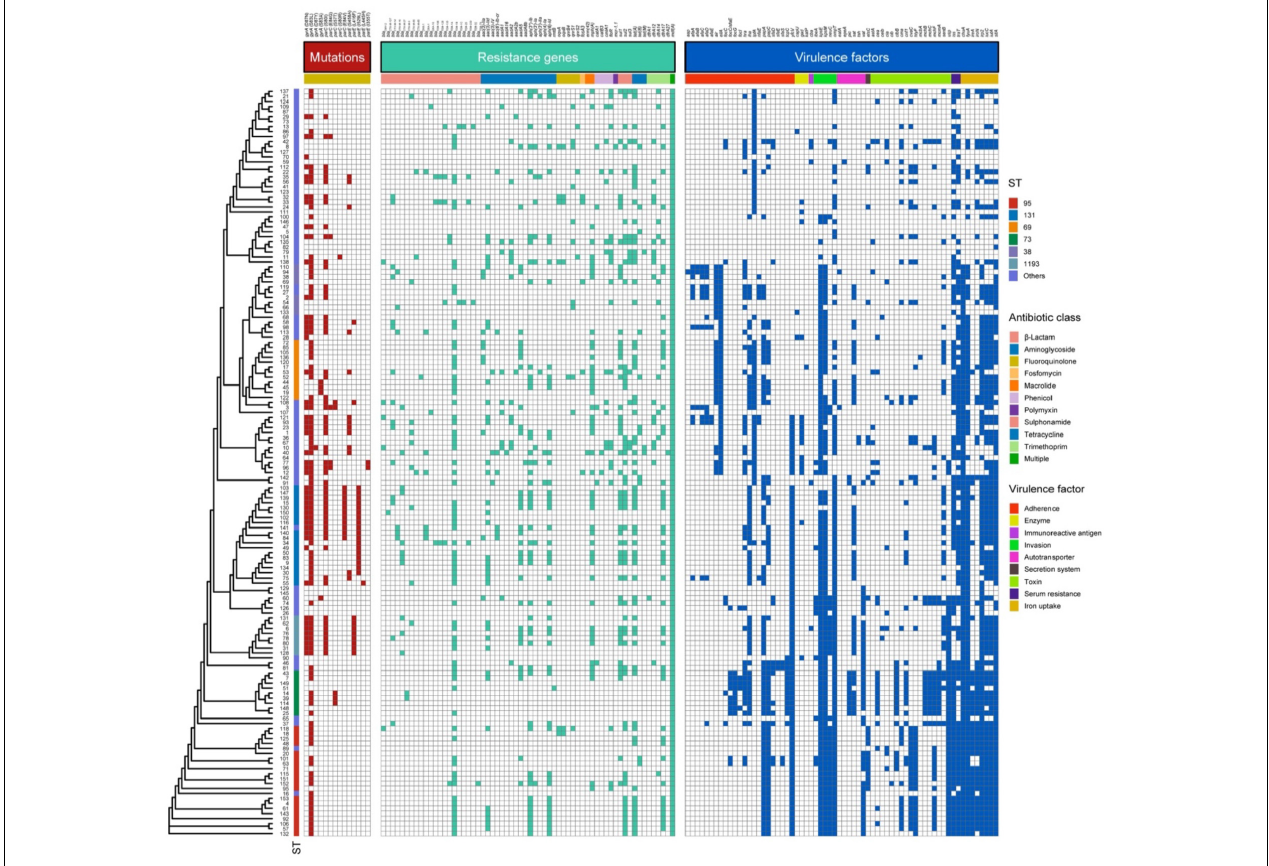
FIGURE 1 | Overall similarity of the 148 E. coli isolates from patients with EC-COBSI based on ST and genomic AMR status. Each line shows the strain number, sequence type (ST), mutations conferring fluoroquinolone resistance, and presence of AMR genes and virulence genes in the genome assembly. Red, presence of mutation; Green, presence of AMR gene; Blue, presence of virulence gene; Blank,